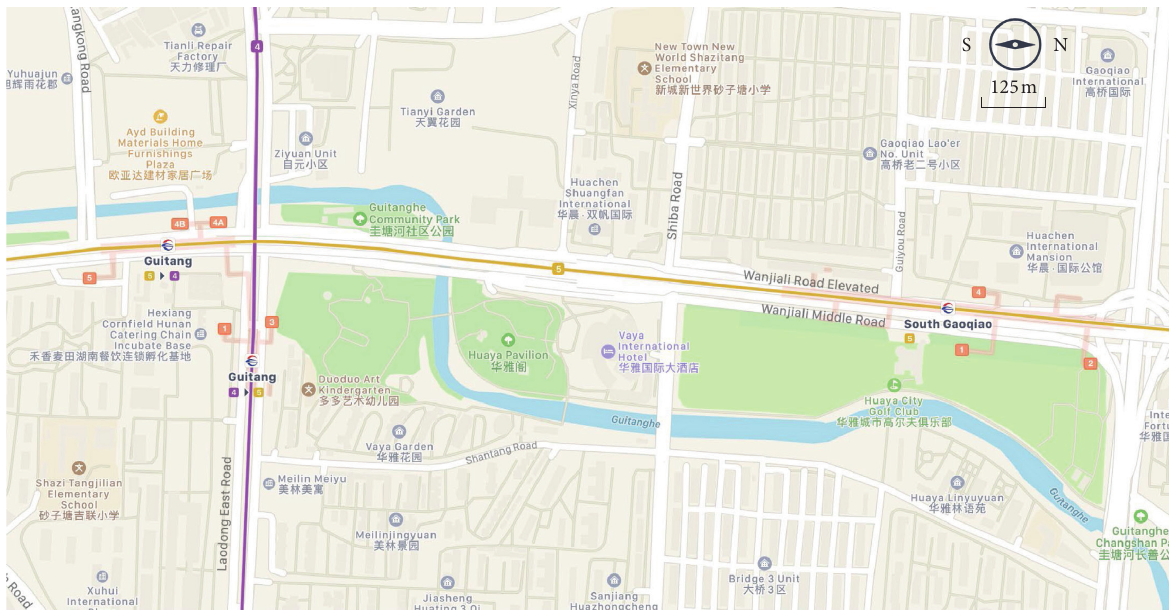
Figure 2: The location of the interval tunnel.